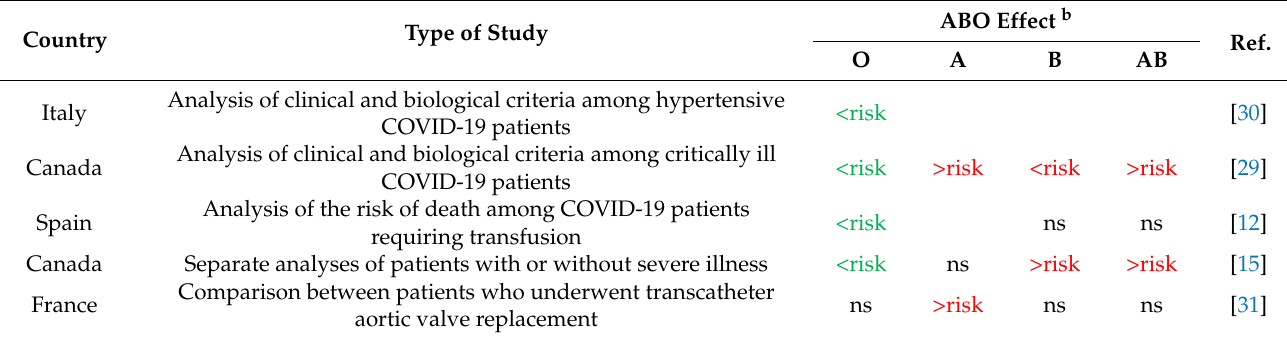
Table 2. Studies specifically analyzing an effect on disease severity a